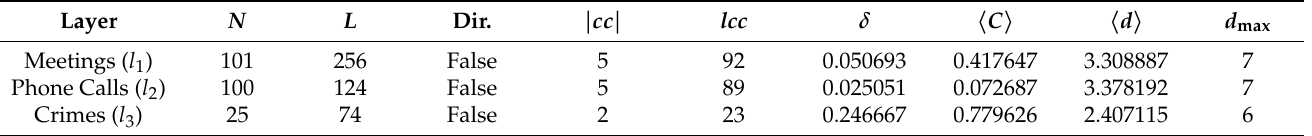
Table 1. Descriptive measures for the flattened Montagna multiplex network and its three layers: number of nodes, number of edges, directionality, number of connected components, size of the largest connected component, density, clustering coefficient, average path length and